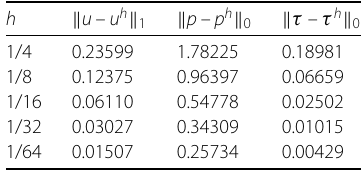
Table 2 The illustration of the error for the Oseen viscoelastic fluid flow without stabilization term for the FE p 1 – p 1 – p 1 dg triples